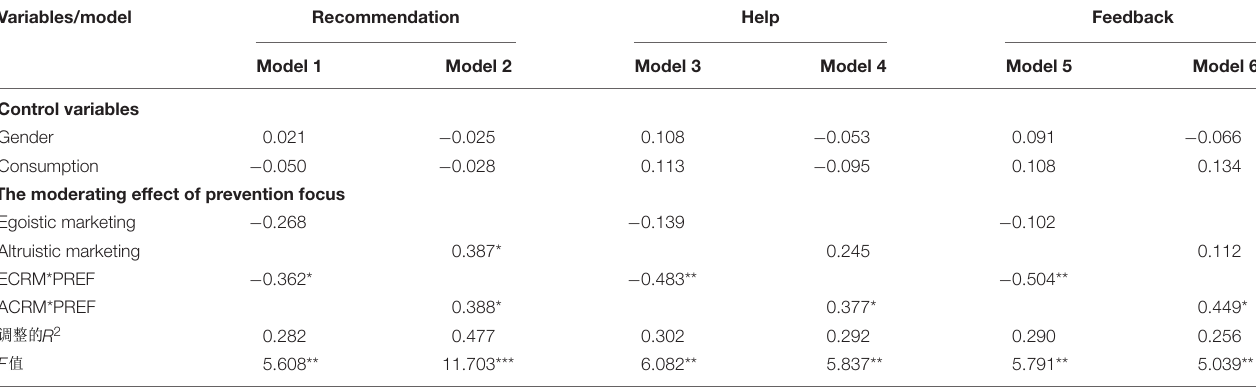
TABLE 4 | Test results of the moderating effect of prevention